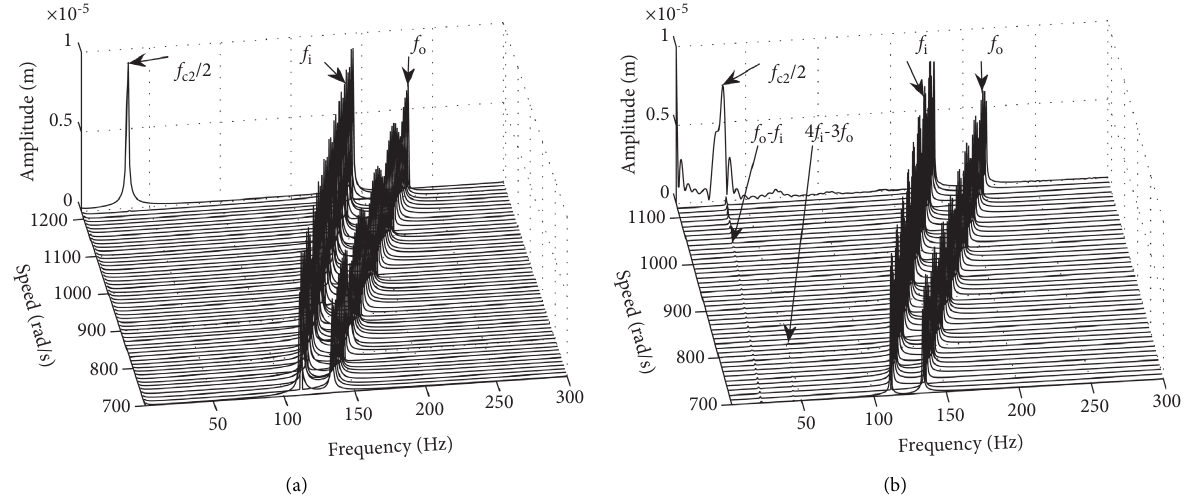
Figure 22: Waterfall plots of the MSDS with K